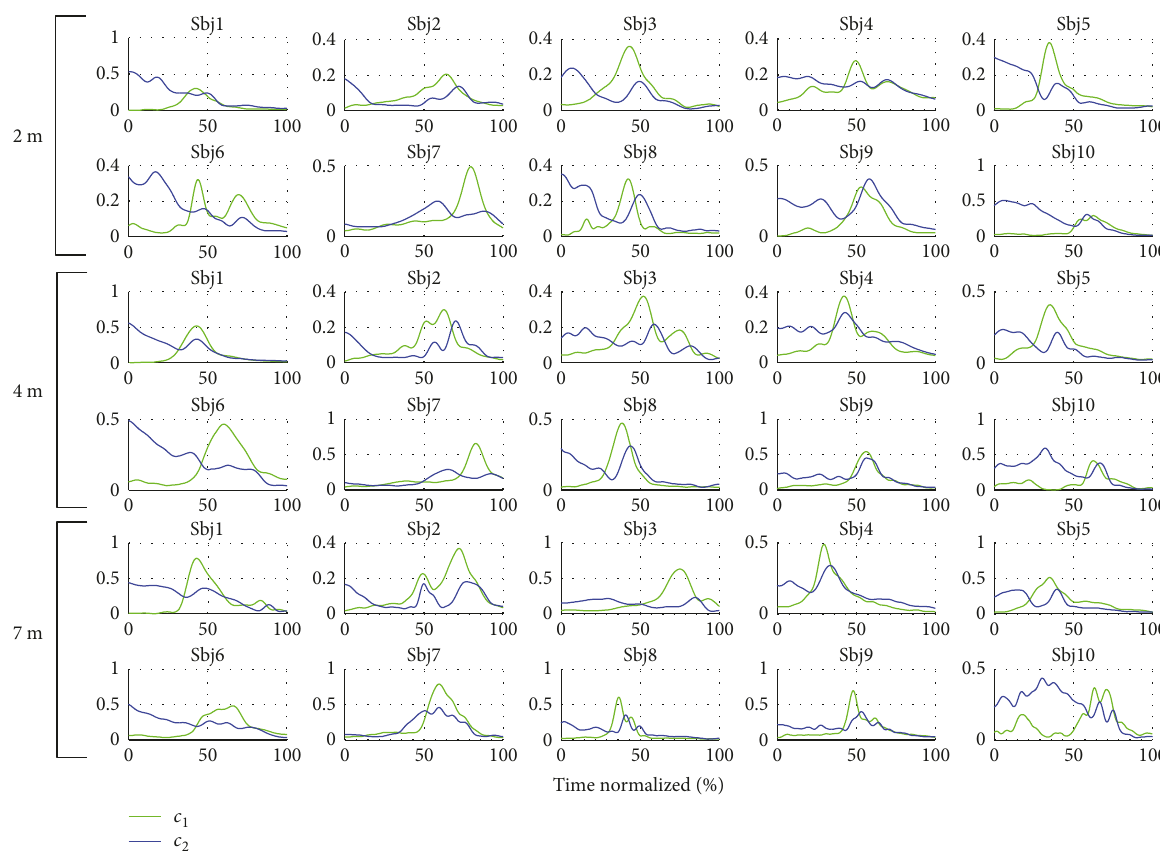
Figure 17: Triggering order and coactivation per subject and throwing distance. A repeatable triggering tendency is seen across subjects: (1) c 2 triggering, (2) c 1 triggering, and (3) c 2 triggering. This sequence is consistent with the expected triggering in ballistic motions.